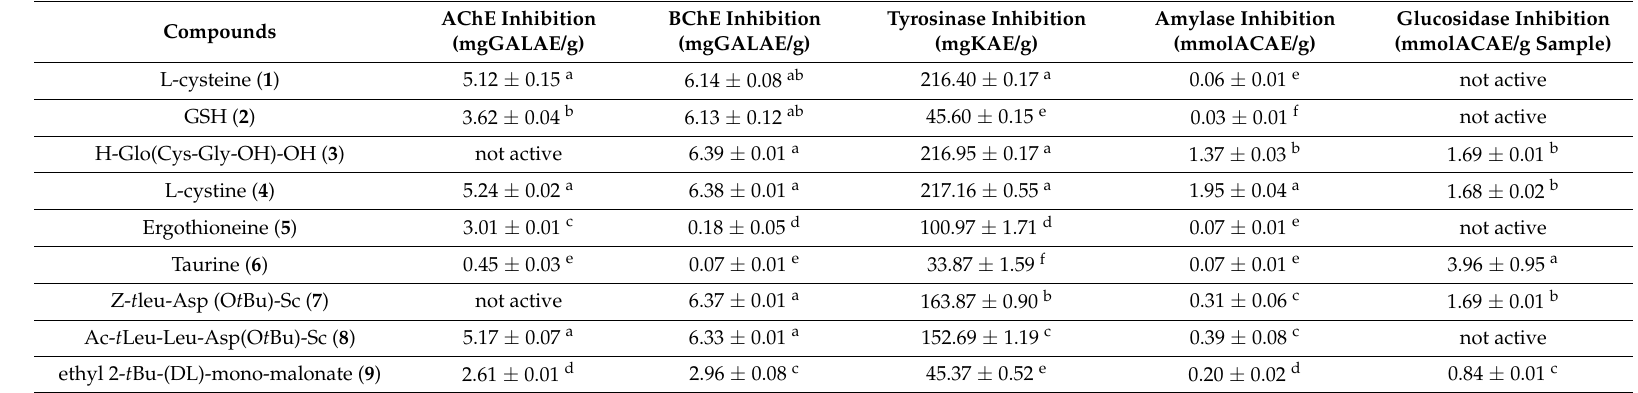
Table 3. In vitro enzymatic assays for compounds 1 –